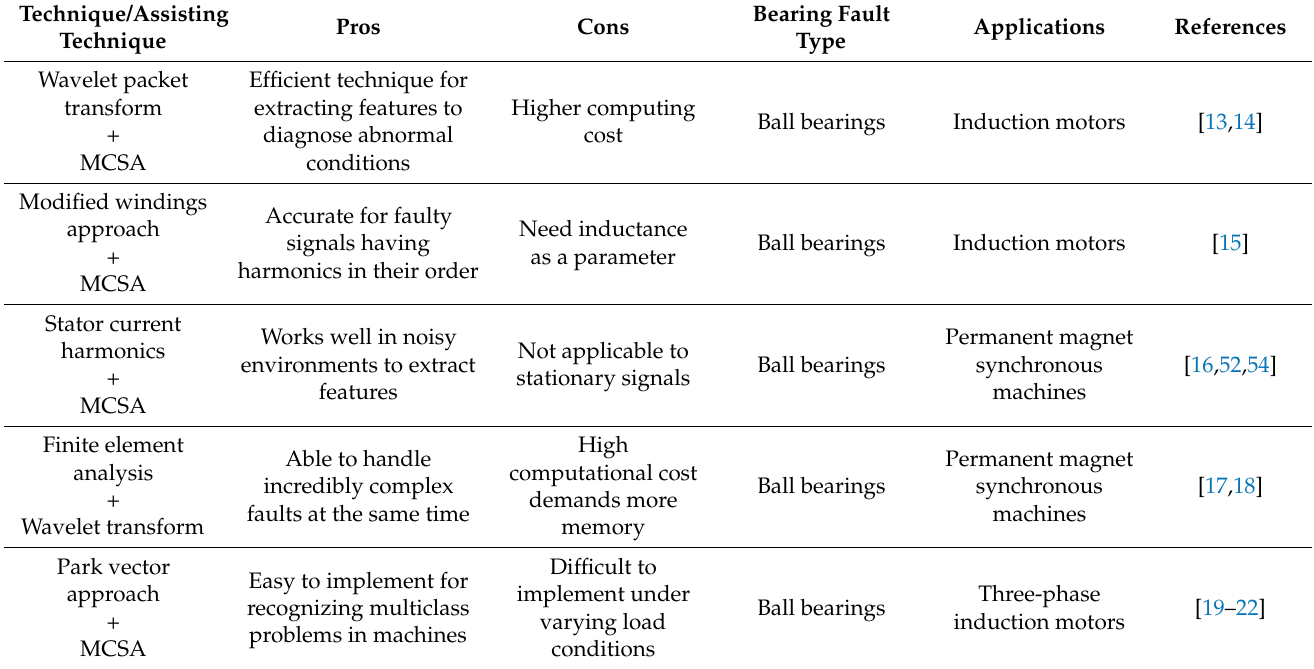
Table 1. A summary of different conventional techniques for bearing fault diagnosis.